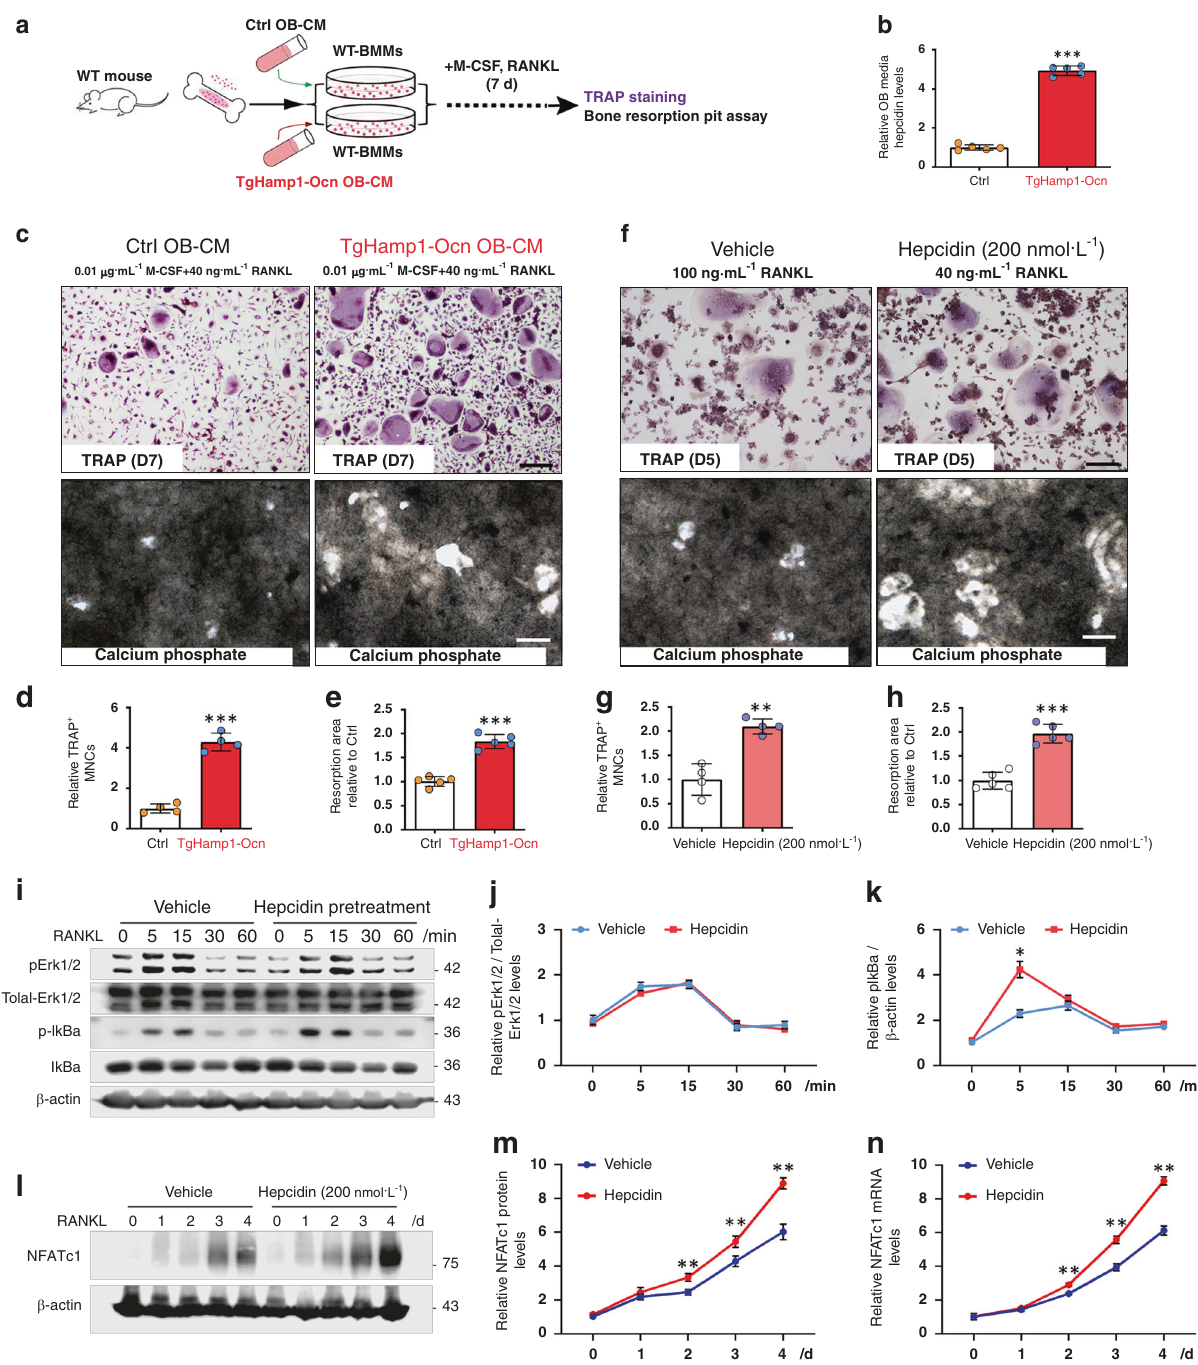
Fig. 4 Hepcidin promotes the differentiation and activation of cultured OC progenitor cells. a Conditioned medium (CM) treatment strategy. b Analysis of hepcidin levels following OB-CM and TgHamp1-Ocn OB-CM treatment by ELISA. CM from fi ve different cell culture experiments for each genotype was used, and the mean ± SD relative to the Ctrl group are shown. *** P < 0.001. c TRAP staining and bone resorption pit analysis of cultured OCs derived from wild-type BMMs in the presence of Ctrl OB-CM or TgHamp1-Ocn OB-CM. Cells were treated with 0.01 μ g·mL − 1 M-CSF and 40 ng·mL − 1 RANKL for 7 d as indicated. Bar, 200 μ m. d , e Quanti fi cation of TRAP + MNCs and quanti fi cation of resorptive activity in c . The data are presented as the mean ± SD of four or fi ve different cell culture experiments. *** P < 0.001. f TRAP staining and bone resorption pit analysis of cultured OCs derived from RAW264.7 cells in the presence of vehicle or 200 nmol·L − 1 hepcidin peptide. Cells were treated with 100 ng·mL − 1 RANKL for 5 d or 8 d as indicated. Bar, 200 μ m. g , h The number of TRAP + MNCs and quanti fi cation of resorptive activity in f . The data are presented as the mean ± SD of four or fi ve different culture experiments. ** P < 0.01; *** P < 0.001. i – k RANKL signaling in RAW264.7 cells was assessed by western blot analysis of lysates stimulated with RANKL for the indicated times. RAW264.7 cells were serum-starved overnight and then pretreated with vehicle or hepcidin (200 nmol·L − 1 ) for 4 h. The data were quanti fi ed by ImageJ software and are presented in ( j ) and ( k ). * P < 0.05. l – n Protein and mRNA expression of NFATC1 in RAW264.7 cells treated with hepcidin were measured by western blot or real-time PCR. The quantitative data were shown in ( m ) and ( n ). ** P <